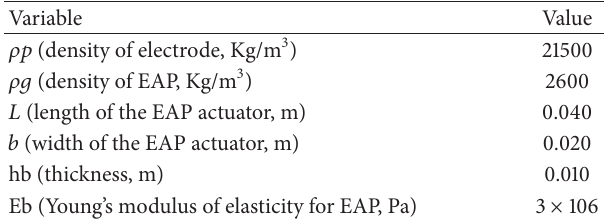
Figure 4: Shape of the central beam in different configuration.